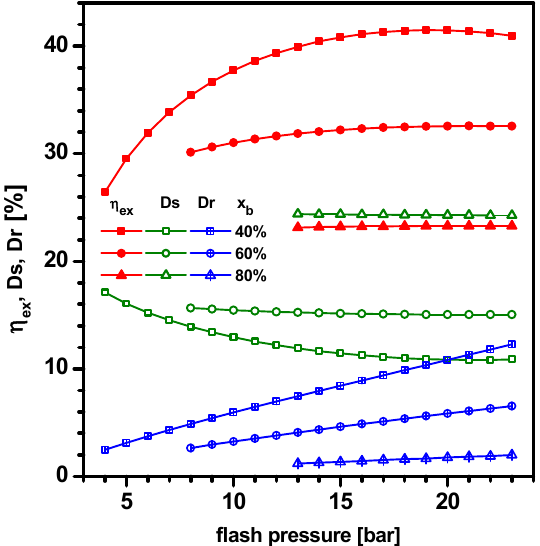
Figure 2. Dependence of η ex , Ds , and Dr on the flash pressure for some values of x b .